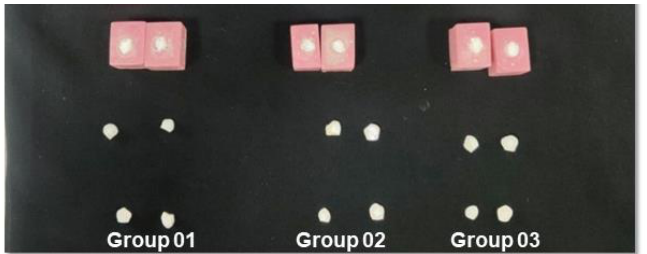
Figure 10. Three different specimen groups were utilized in the present study to assess the remin- eralization potential of the developed materials. Group 1 contains the tooth GC-Tooth-Mousse com- mercially available product, and Group 2 comprises thermal HA from the fish bone; Group 3 in- volves the alkaline HA from the natural fish